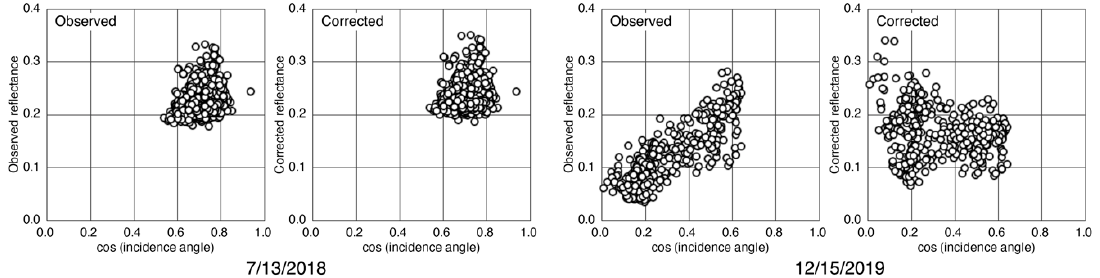
Figure 16. Comparison of observed and SCS + C corrected reflectance in a summer scene ( left ) and a winter scene ( right ). The horizontal axis represents the local solar incident angle.